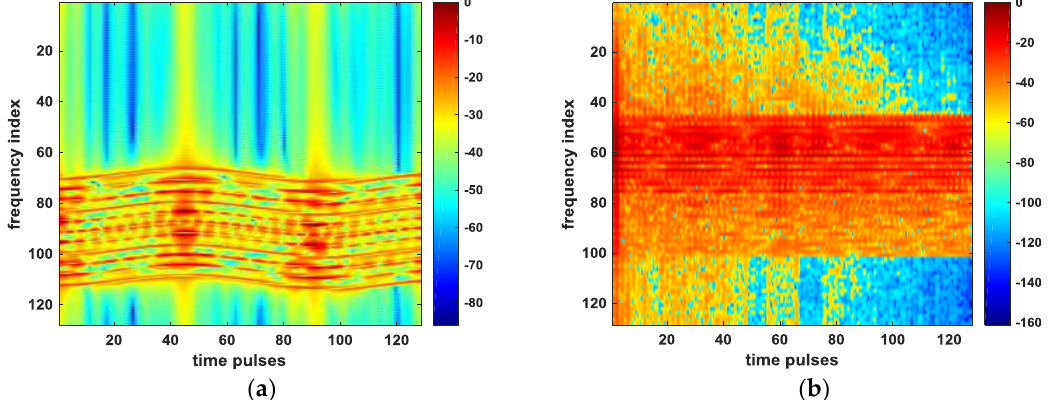
Figure 13. Spectrograms of time pulses. ( a ) before applying the proposed method; ( b ) after applying the proposed method.